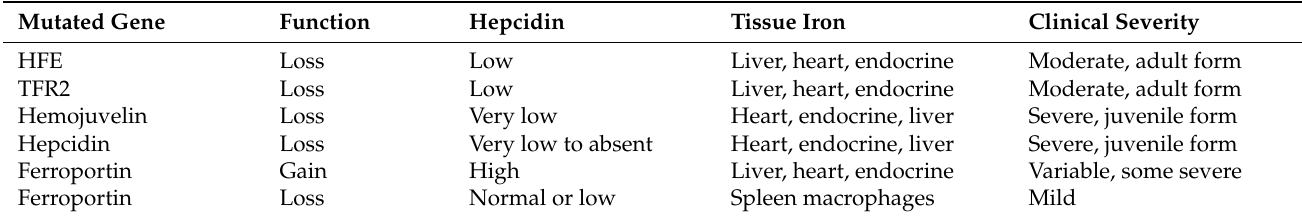
Table 2. Forms of hereditary